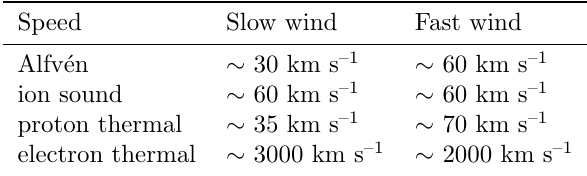
Table 7: Typical values of different speeds obtained at 1 AU. The Alfv´en speed has been measured, while all the others have been obtained from the parameters reported in Table 6.